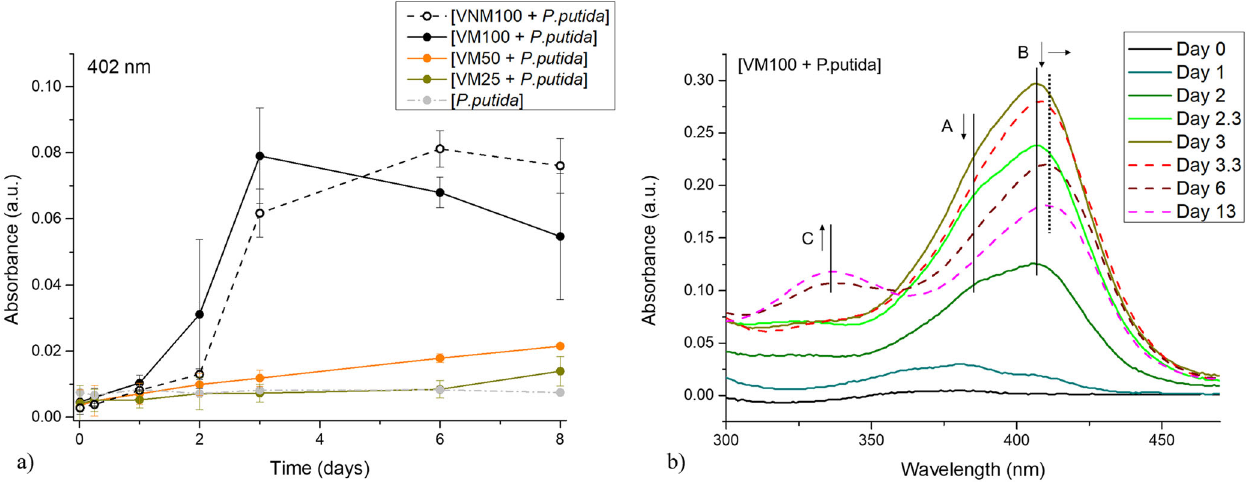
Fig. 4 UV-VIS absorption results. a Measurements at 402 nm, plotted versus time for all the biotic conditions tested, uncertainty bars correspond the standard deviation for the two set of experiments. b Absorption spectra (300 – 500 nm) obtained at different altering times for a the 13-day experiment of [VM100 + P. putida